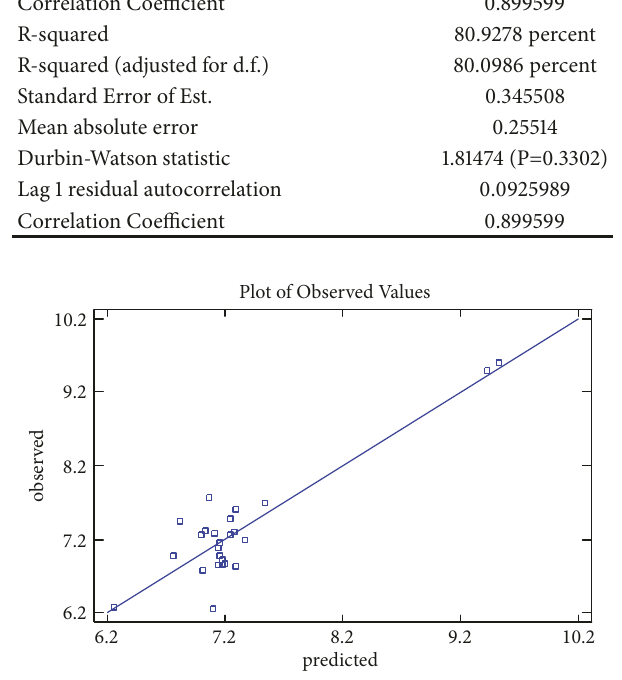
Figure 5: Plot of observed versus predicted values.